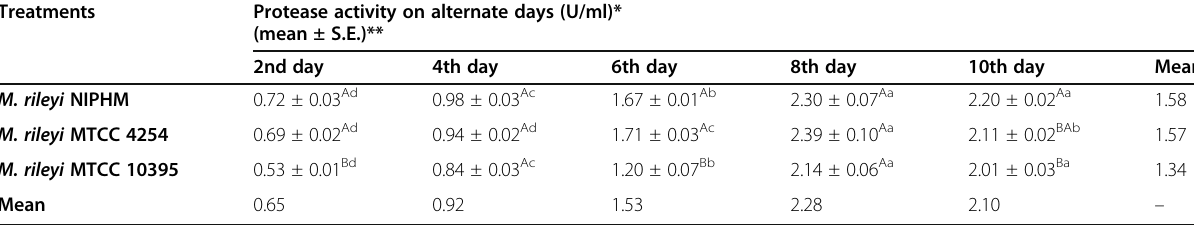
Table 3 Protease activity of Metarhizium rileyi isolates on different days after inoculation